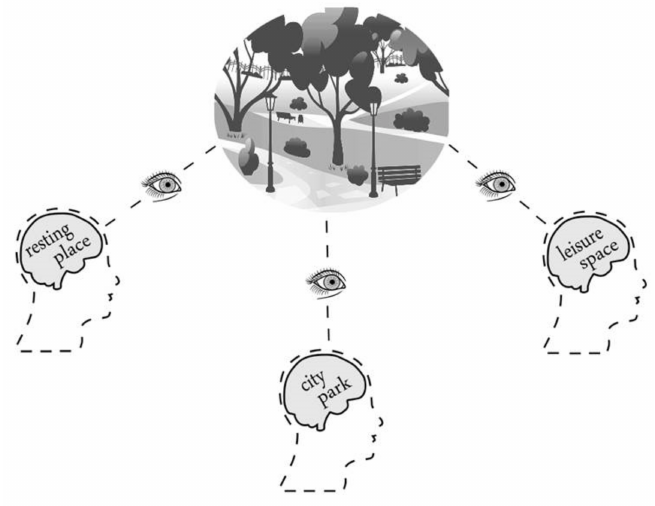
Figure 1. The perception of